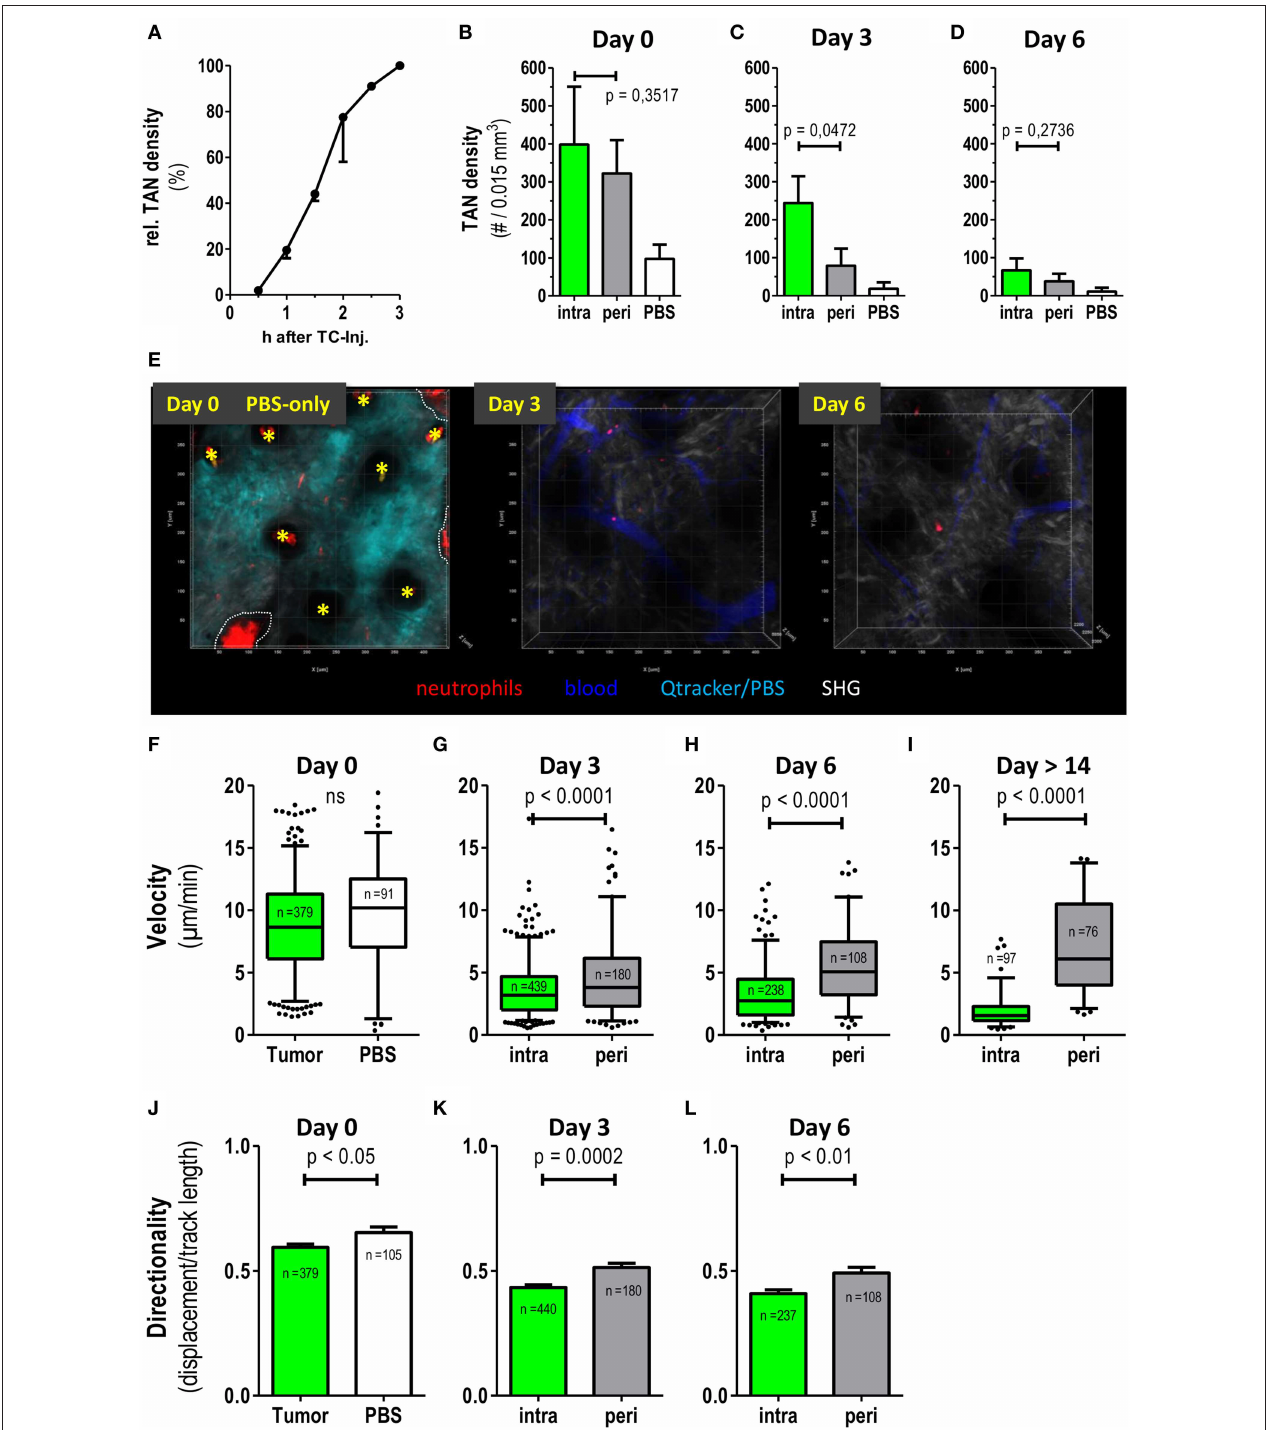
FIGURE 2 | Differential recruitment and migratory patterns of intratumoral vs. peritumoral neutrophils. Catchup IVM − red mice were injected with MOPC EGFP cells into the dorsal ear dermis. TAN infiltration and motility was assessed by transdermal intravital 2PM. (A) Time course of TAN recruitment during the first 3h after tumor cell inoculation. TAN density at 3h was defined as 100% (mean with SEM of 2 representative mice is shown). (B–D) Neutrophil densities were quantified in intratumoral (green bars) and peritumoral (gray bars) compartment and after PBS injection only (white bars) at days 0, 3, and 6 and depicted as number of TAN per 0.015 mm 3 tumor tissue volume ( n = 6 mice for tumor and n = 2 mice for PBS). (E) Representative 2-D still images generated from three-dimensional multiphoton images in